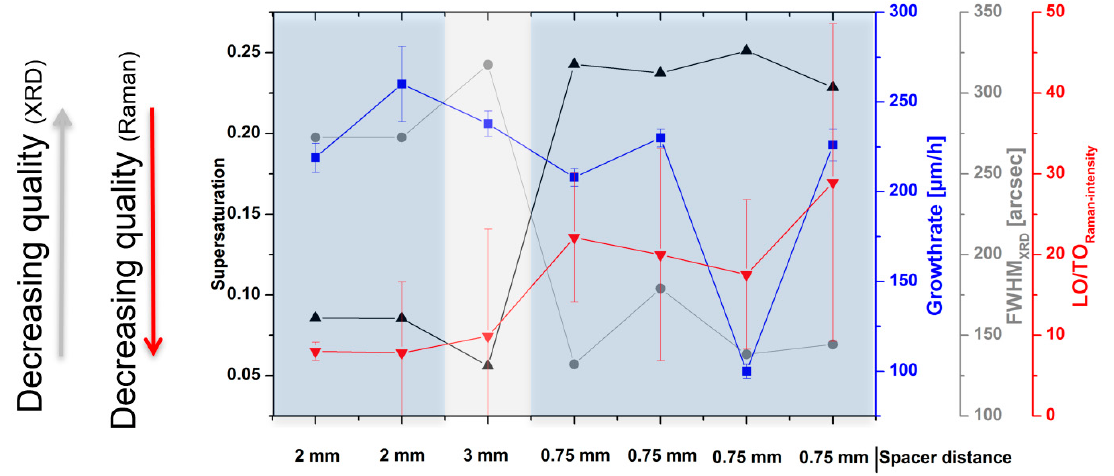
Figure 3. Calculated supersaturation for SiC 2 gas species for different experiments. Additional information is provided by growth rate (blue) and spacer distance. Analysis data (gray) is extracted from XRD measurements of the 002 peak and the FWHM. Raman data shows the intensity ratio of the LO and the TO mode (red).